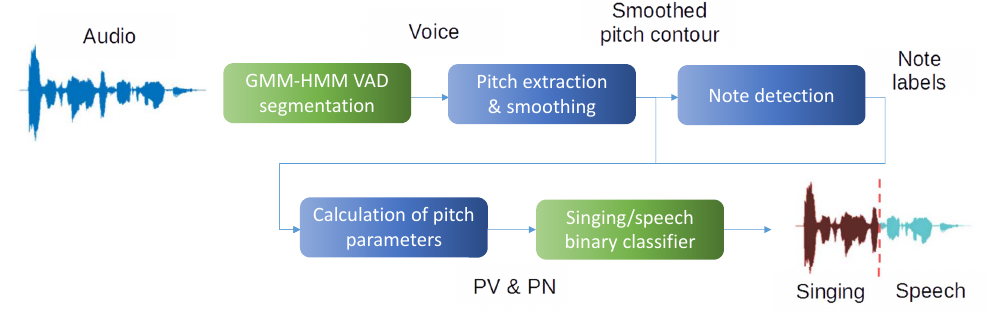
Figure 2. Structure of the proposed speech/singing voice segmentation